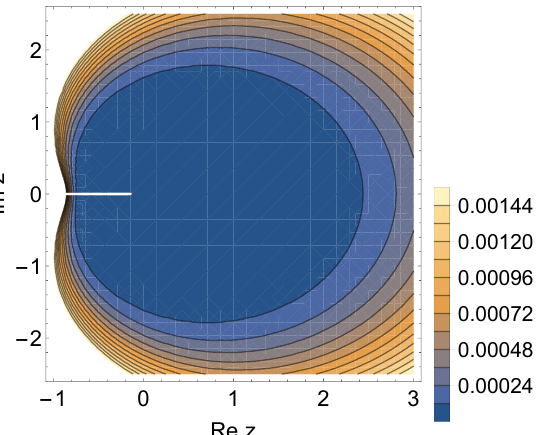
( z ) of (53) guarantees certain truncation error bounds 8